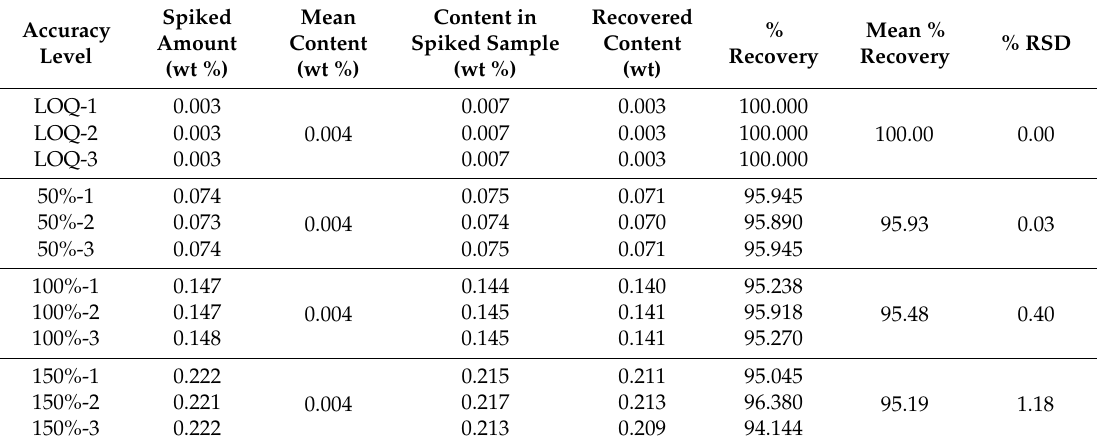
Table 5. Accuracy of S -enantiomer detection in the rasagiline mesylate mixture at various concentration levels.